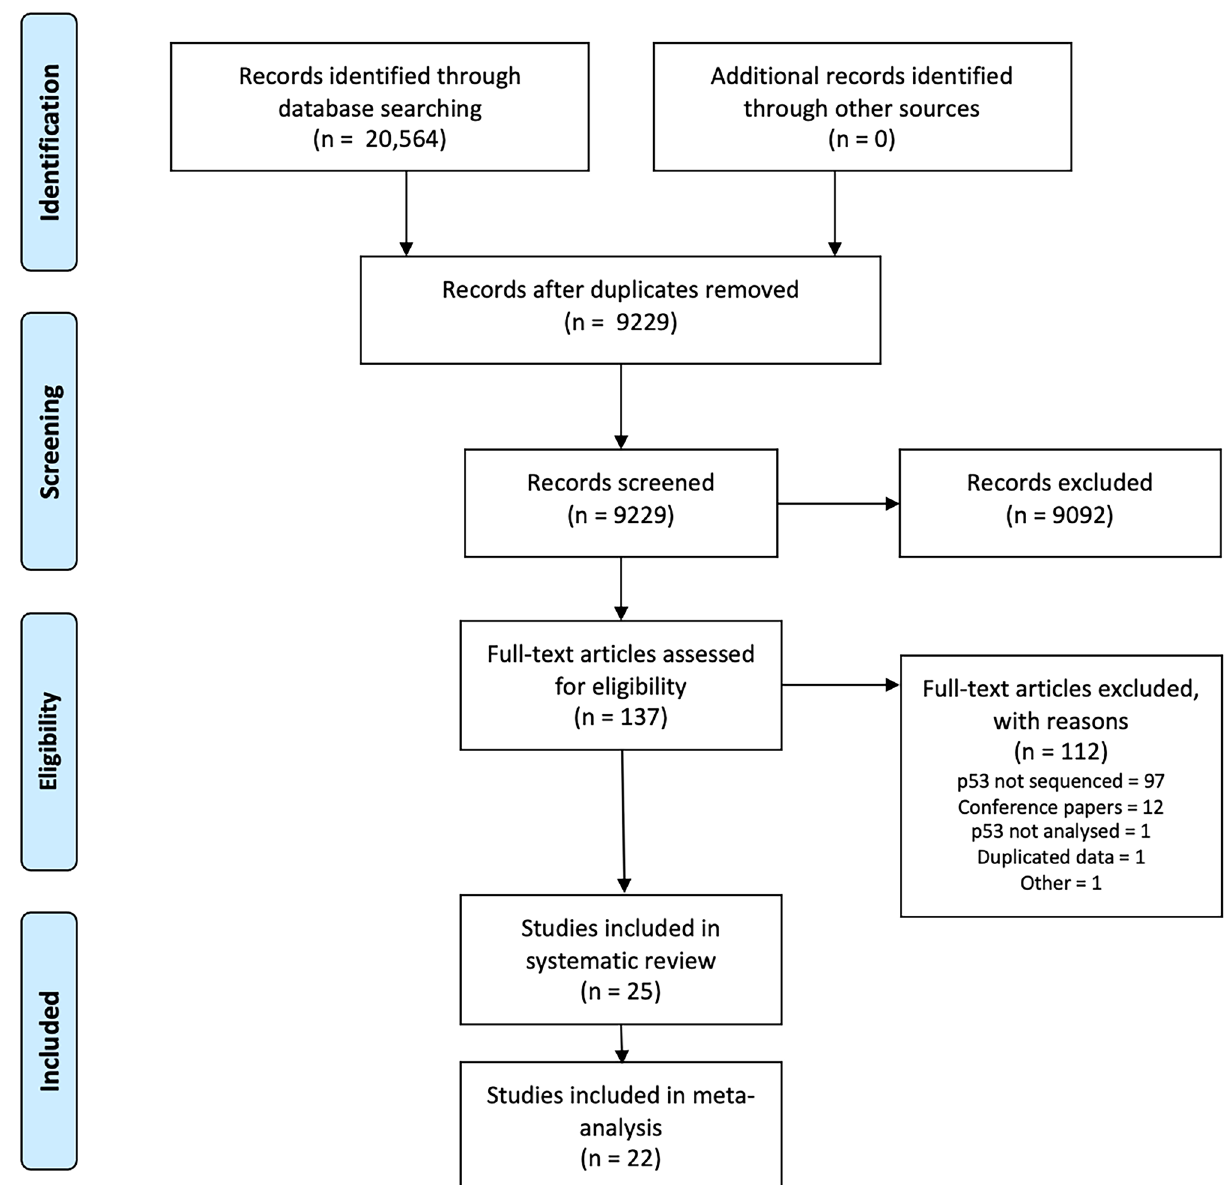
Figure 1. Flow diagram of the process of identification and selection of studies examining the effect of p53 mutation on survival in head and neck